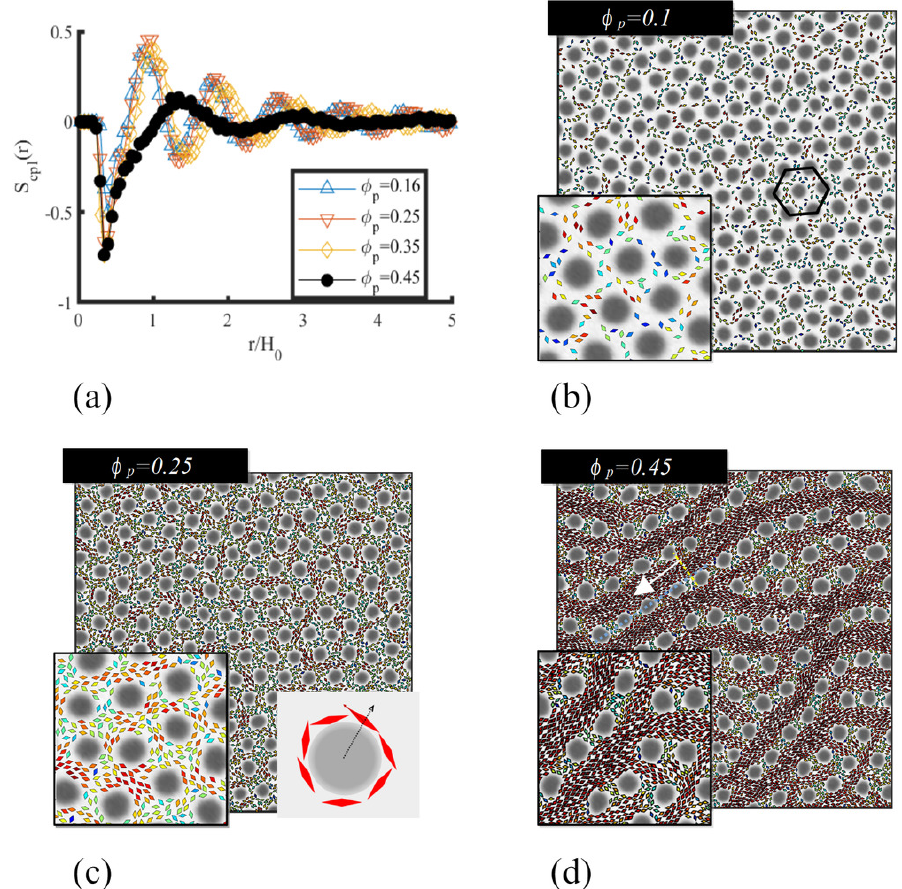
Figure 18. Nematic ordering of rhomboidal NPs ( e = 1/2) within the majority phase of circle-forming BCP ( f 0 = 0.6). ( a ) shows the coupling nematic order parameter S cpl ( r ) in function of the distance to the center of BCP domains. ( b – d ) show the snapshots as the concentration grows, respectively, for φ p = 0.1, 0.25 and 0.45. Reprinted with permission from Ref. [170] Copyright 2022